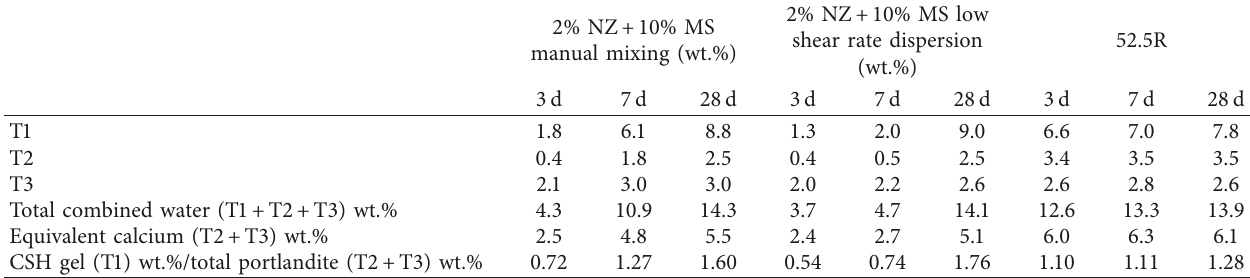
Table 2: Water losses associated with different phases in cement pastes with 2 wt.% of nanozinc (NZ) +10 wt.% microsilica (MS).